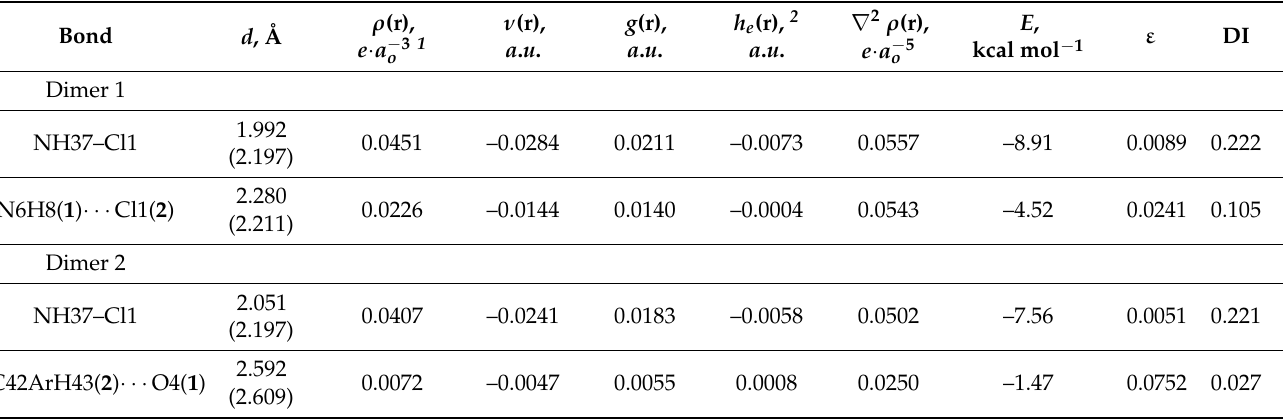
Table 3. Topological characteristics of the non-covalent bonds calculated by the QTAIM method for the methylone